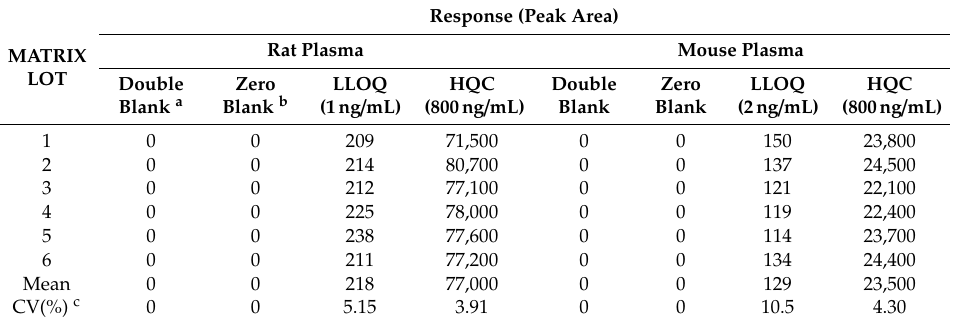
Table 1. The specificity of SH-1242 in rat and mouse